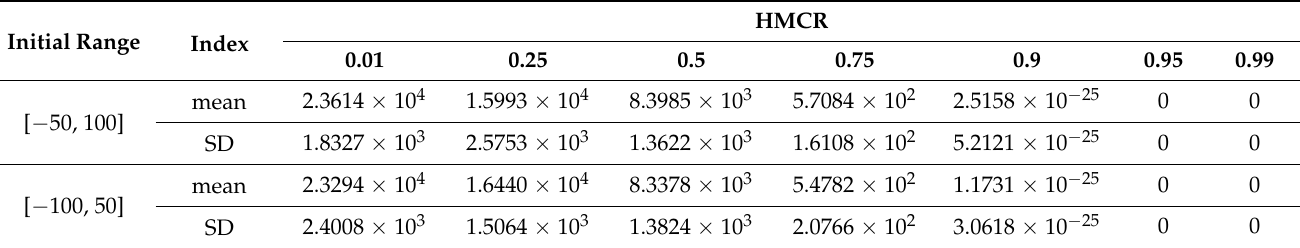
Table 1. Numerical results with different HMCR values for Sphere.